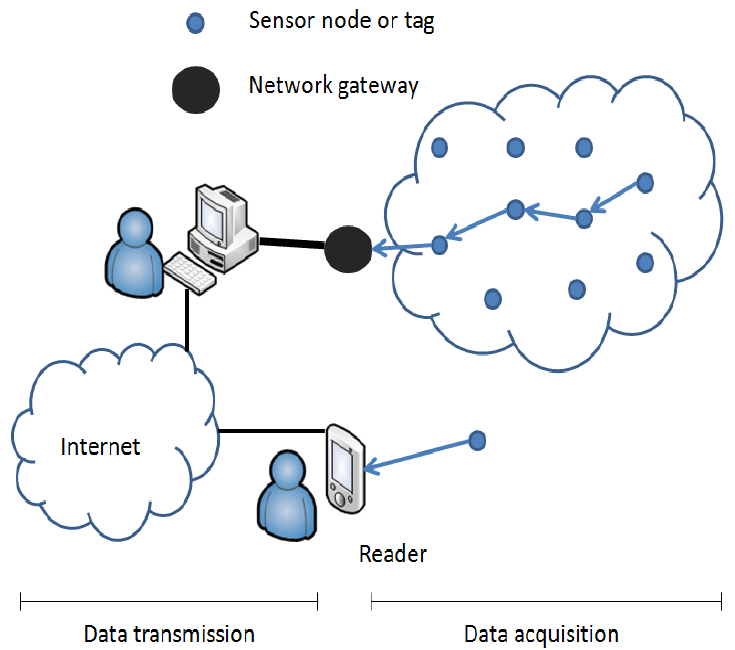
Figure 1. Remote and near field access